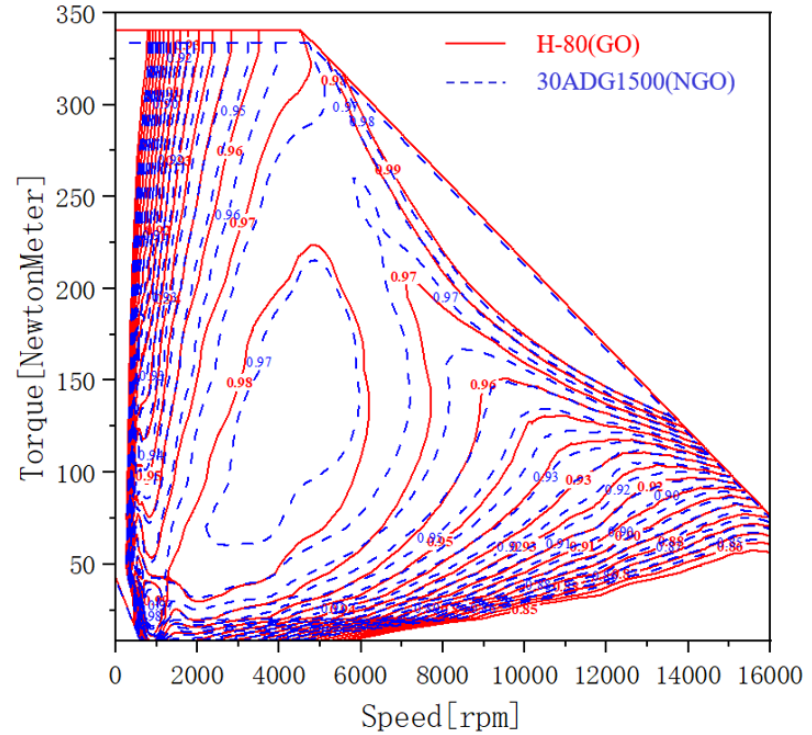
Figure 14. Comparison of efficiency map between traditional non-grain-oriented silicon steel motor model and grain-oriented silicon steel motor model.